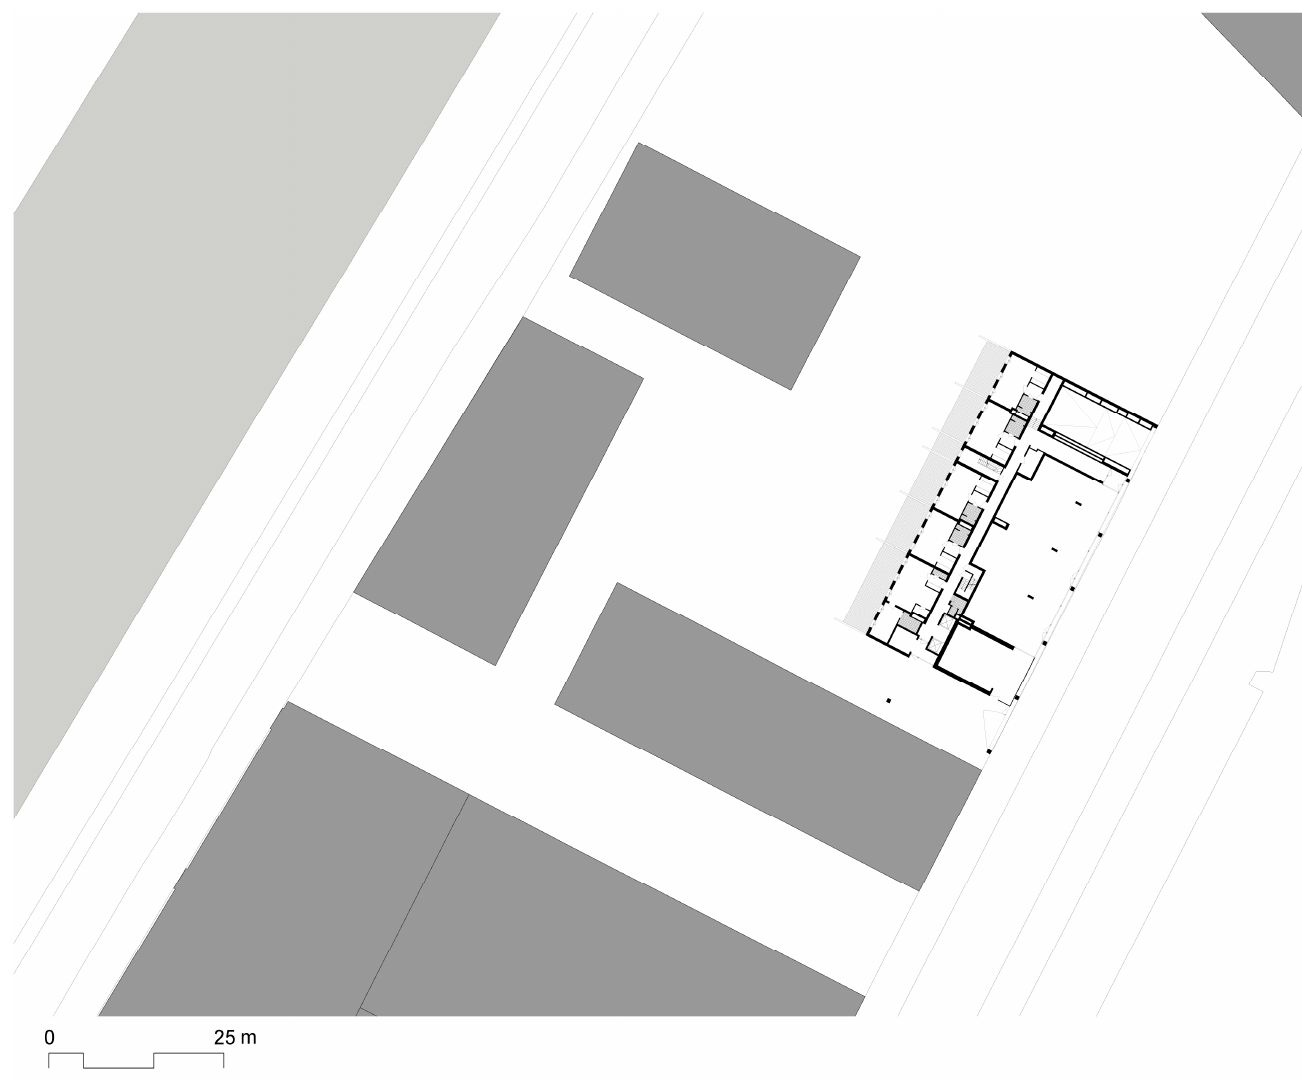
Figure 7. Urban layout of the project “Bpost” by 51N4E (re-drawing by the authors).